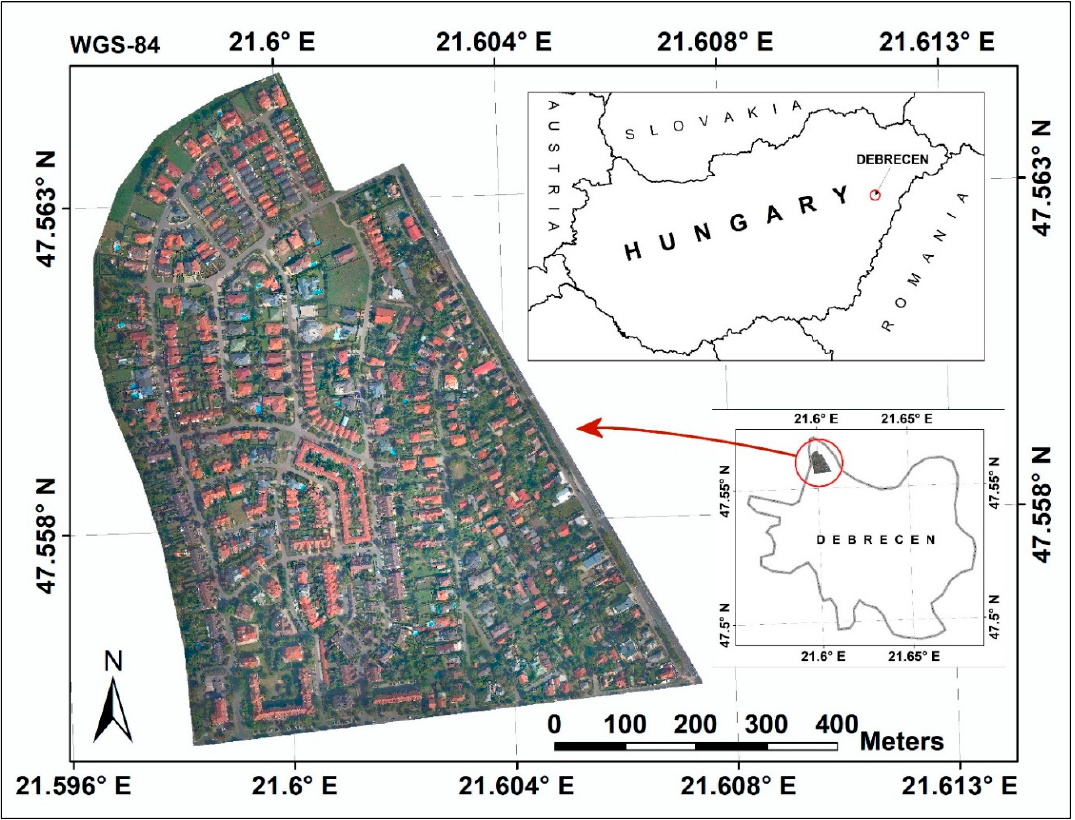
Figure 1. Location of study area.